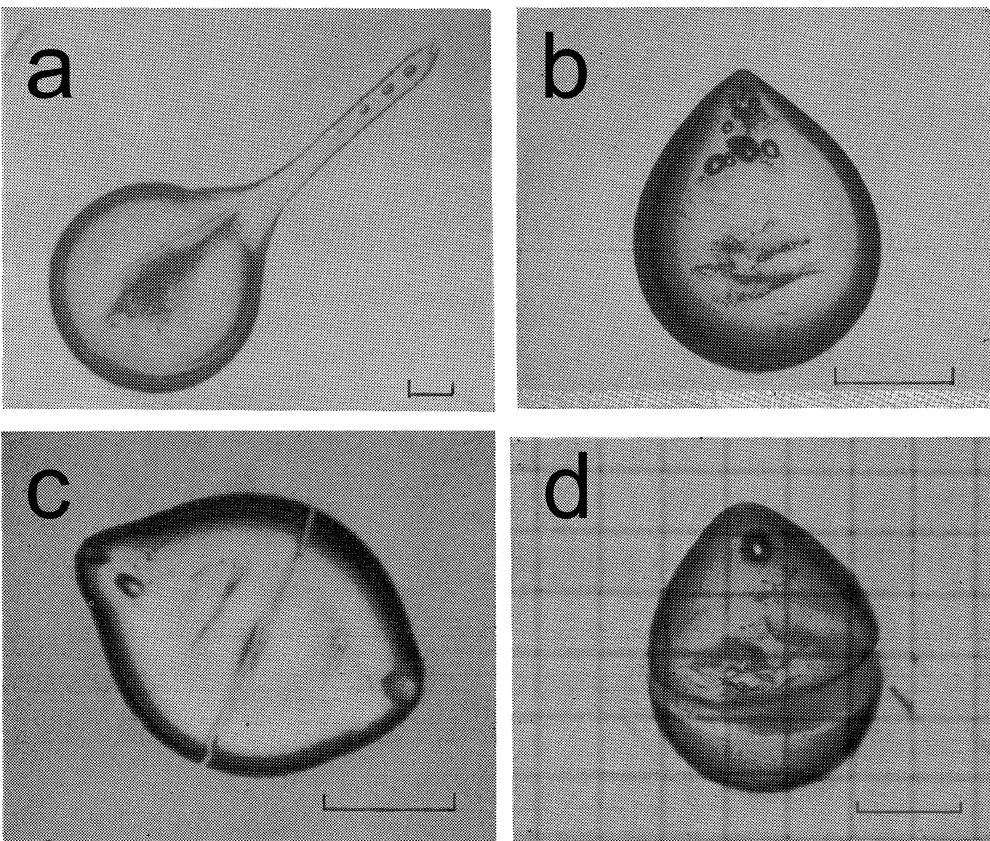
Figure 7. The main types of droplet deformations during freezing. (a) Spike: long thin protrusion usually longer than one-fourth of the drop diameter; (b) bulge: protrusion shorter than one-fourth of the droplet diameter; (c) crack; (d) split. Scales are 100µm. Adapted from Takahashi